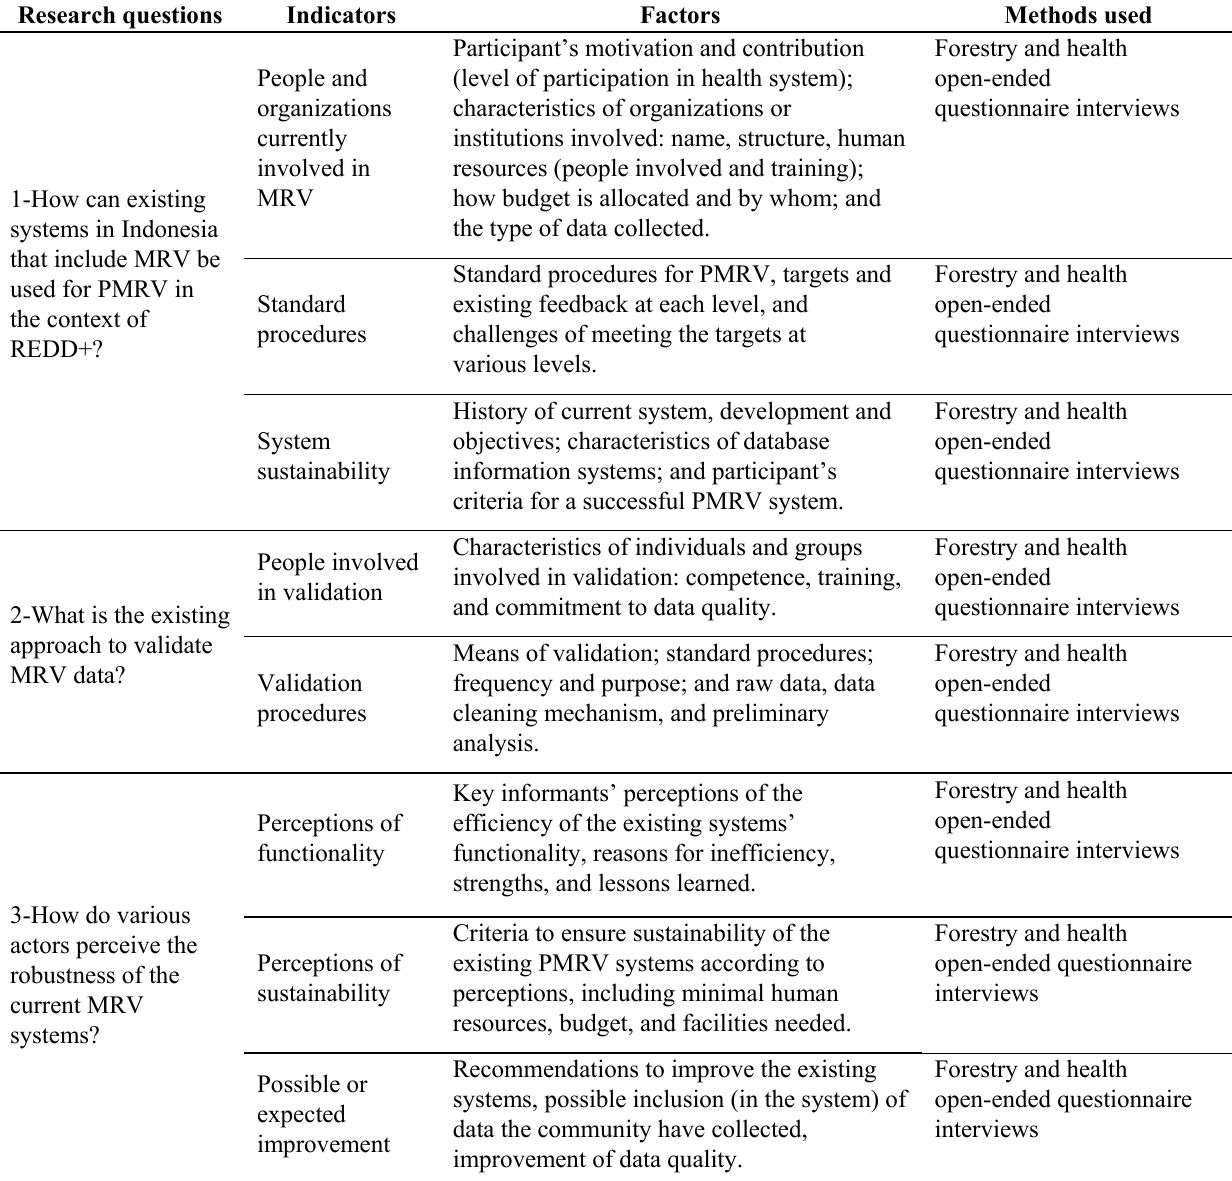
Table 4. Research design for the multilevel governance study on reporting in the health and forestry